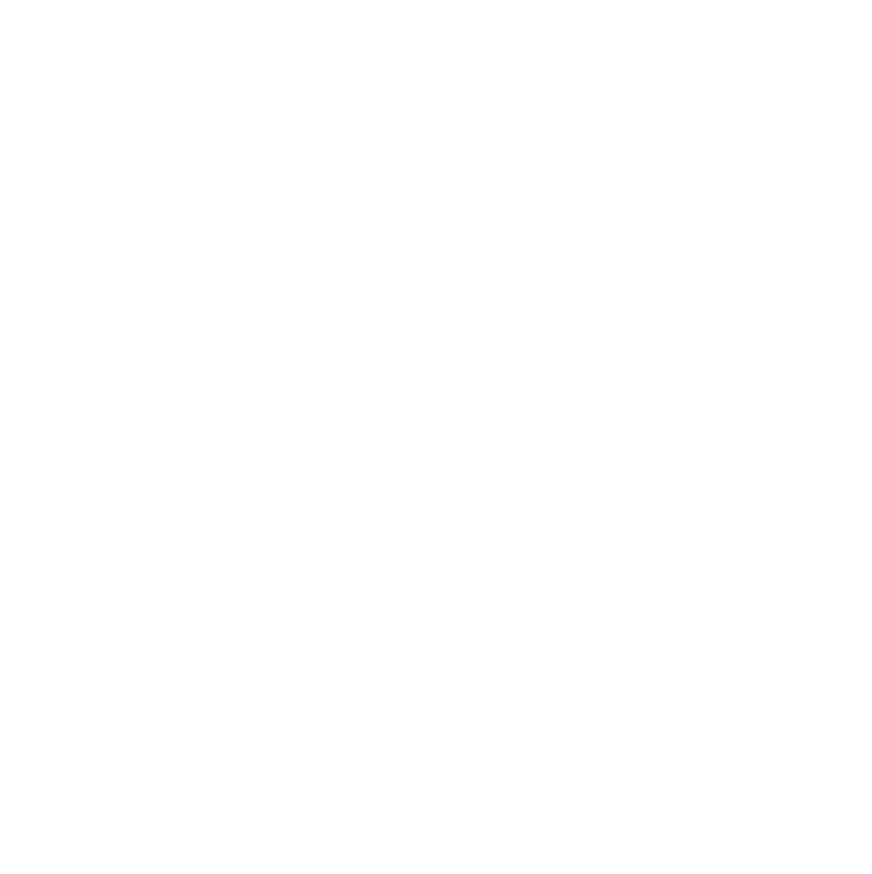
FIGURE 1 | Flow chart and retension rates of the MARI father study. F-T1 week 22 to 24 of gestation, F-T2 at 10 days postpartum, F-T3 at 4 months